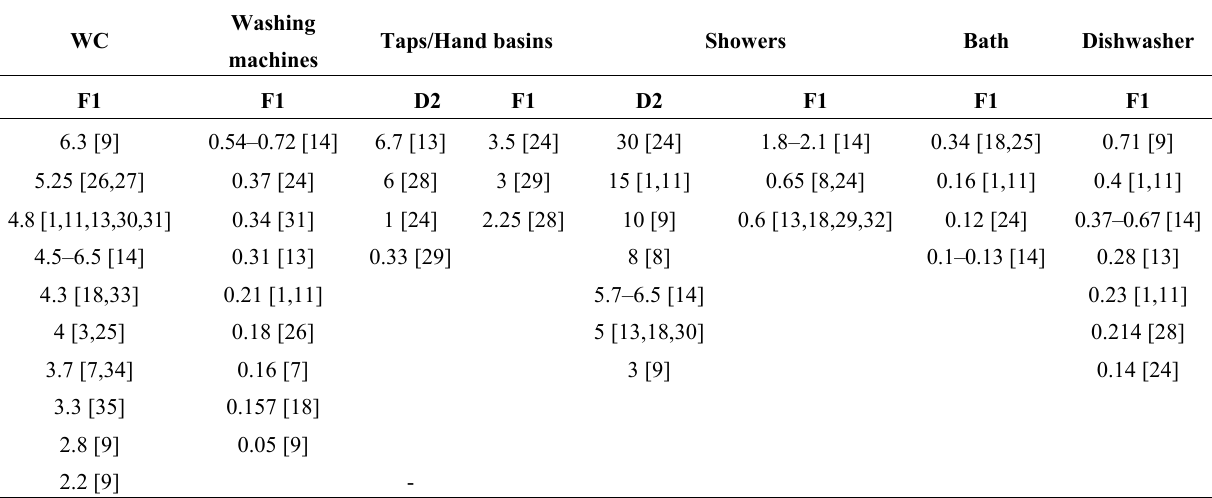
Table 2. Domestic user behaviour of an individual: frequency (F) of use and duration (D) ranges. WC